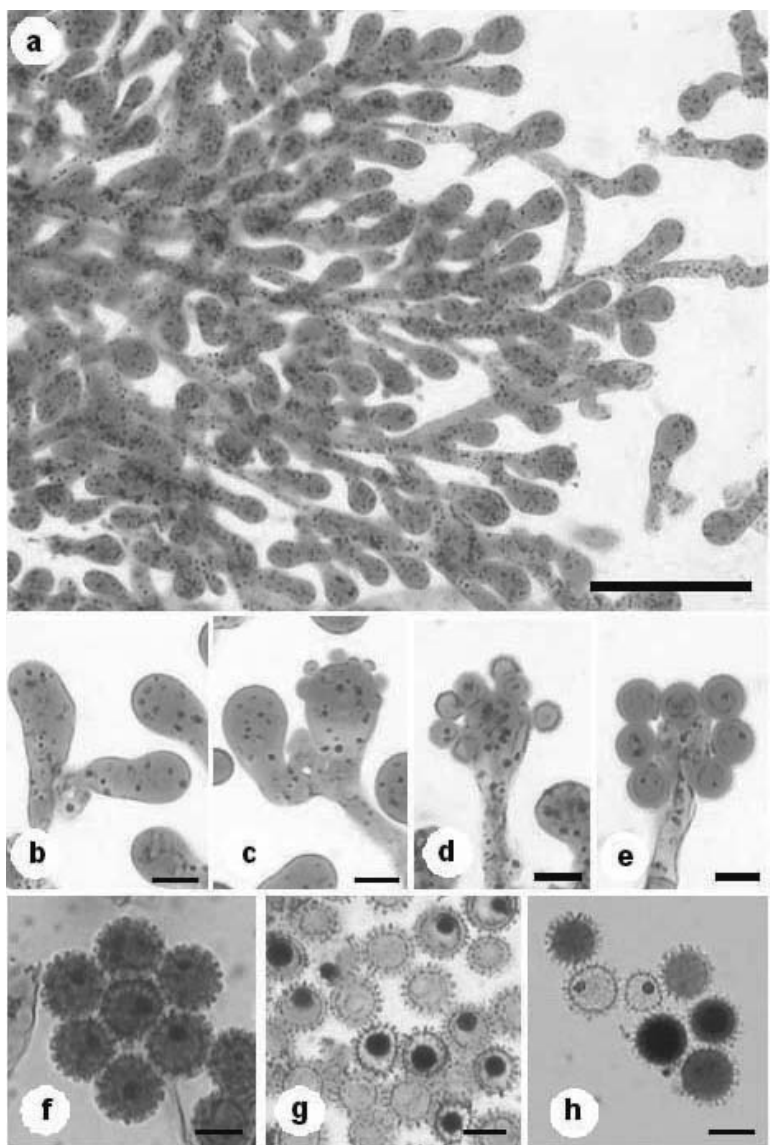
Figure 1. Hyphae, basidia, and basidiospores of Pisolithus sp., stained with Congo Red and Sudan Black B, showing the lipid distribution (black inclusions) in the fungal structures. (a) Abundant lipid distribution in young basidia and hyphae. (b) Lipids in a connection clamp located at the base of basidia. (b to g) Progress of lipid accumulation during basidiospore development. (h) Storage lipids in mature basidiospores taking the whole internal space of the spore (light brown to black spores). Bars: a = 30 µµµµµ m; b to h = 5 µµµµµ